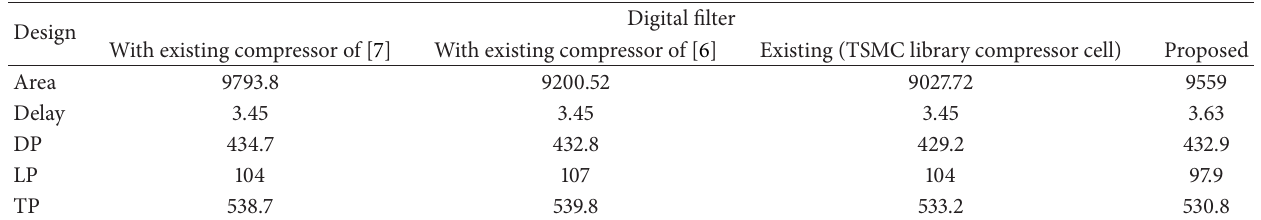
Table 3: Results of digital filter with existing and proposed compressor architecture.